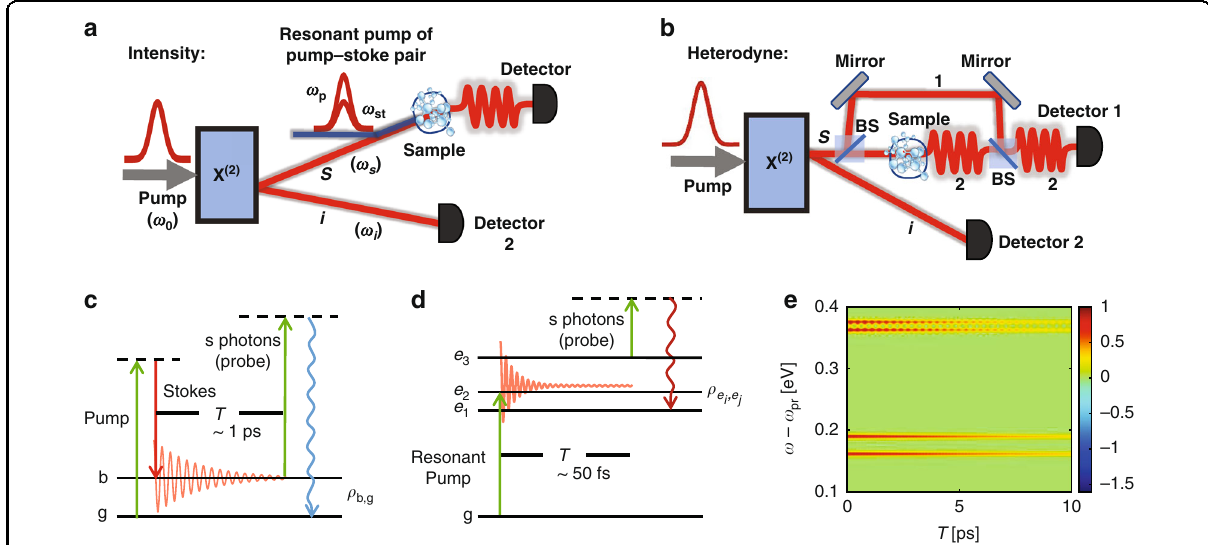
Fig. 1 a Schematic of entangled twin photons as ultrafast probe for molecules, where the parametric down conversion through a beta barium borate (BBO) crystal and multi-photon detection are presented. b Quantum heterodyne scheme of detection where a local oscillator interferes with emitted photons in s arm; Detector 1 records the interference term whereas detector 2 records the idler photon number, yielding the joint detection. c Level scheme of microscopic model in Quantum FAST CARS. d Level scheme of microscopic model in QFRS for electronically excited states. e Quantum FAST CARS signal from Eq. (6), taking the 4 Raman-active modes A 1 , E and T 2 in methane (CH 4 ), where the parameters are σ (cid:2) 1 ¼ 16ps, 20ps, 15ps, probe and γ (cid:2) 1 bg